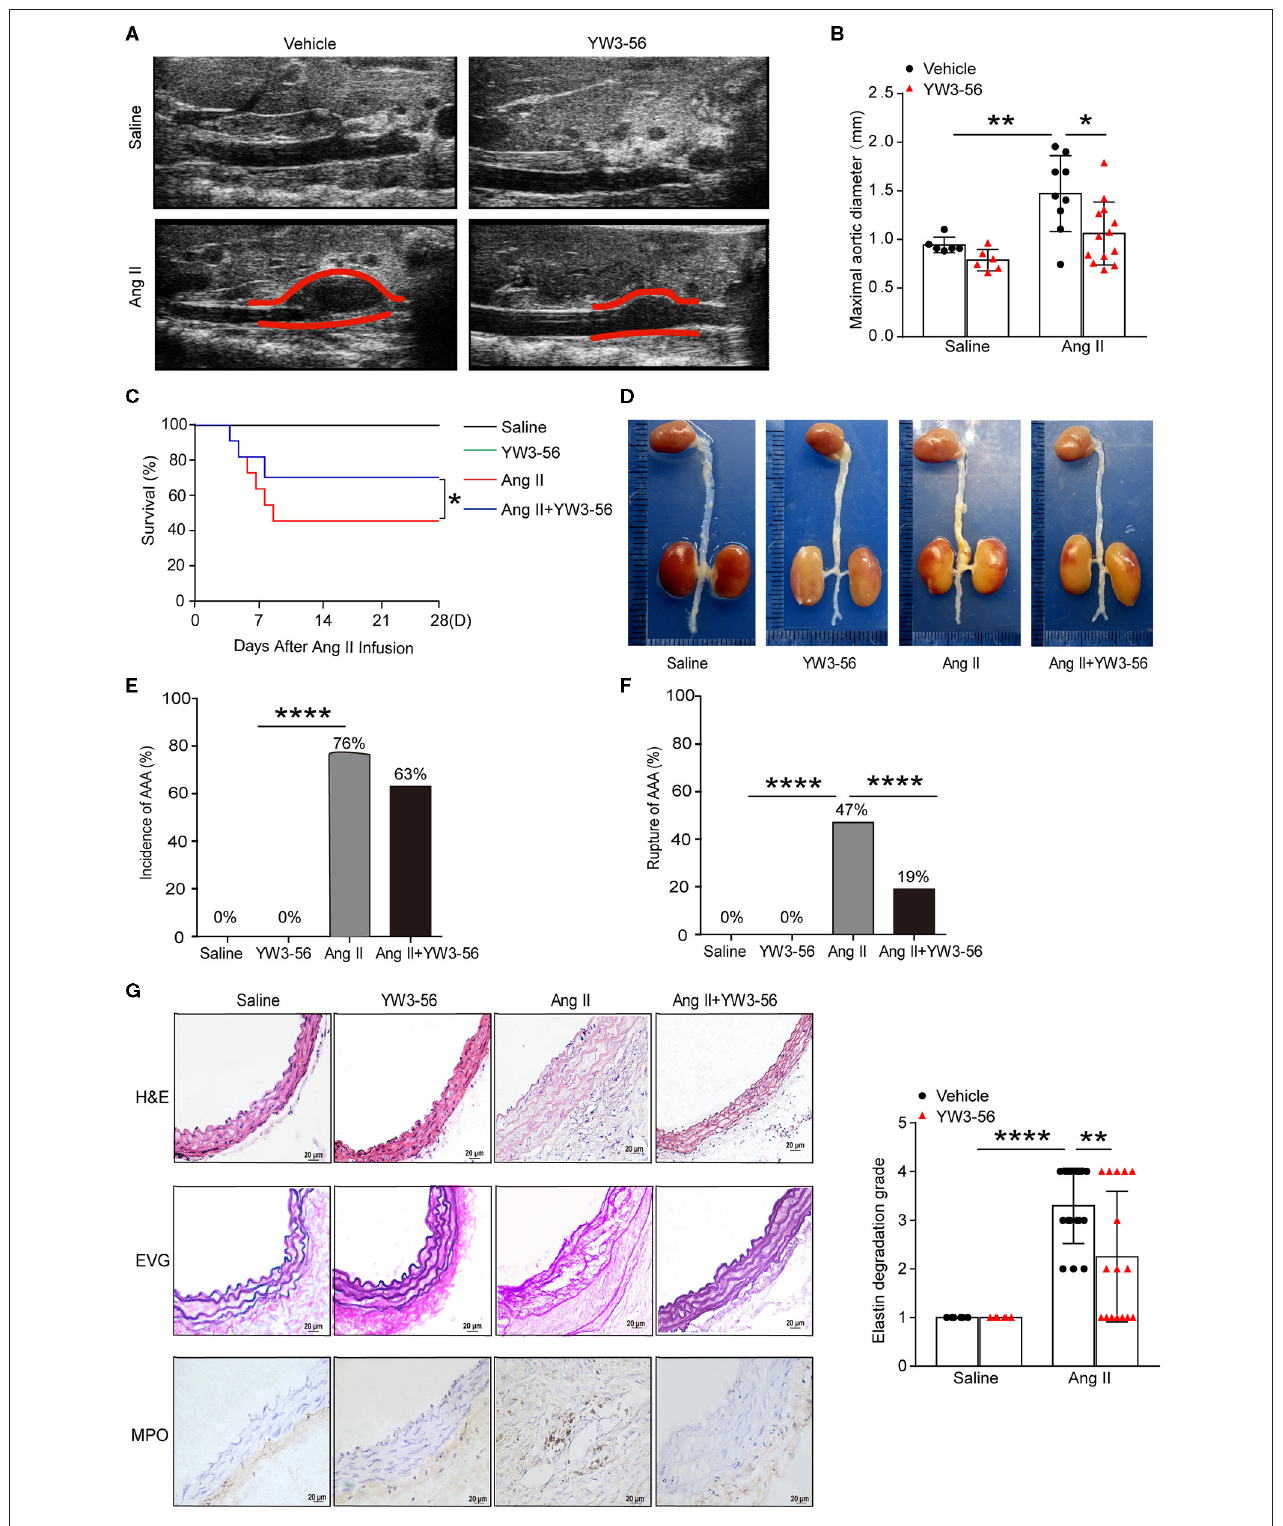
FIGURE 4 | PAD4 inhibitor YW3-56 reduced Ang II-induced AAA rupture. ApoE − / − mice were infused with saline or 1,000 ng/kg/min Ang II for 28 days in the presence of vehicle or YW3-56. (A) B-mode ultrasound of abdominal aortas and (B) statistical analysis of maximal aortic diameter. n = 6/saline group, n =